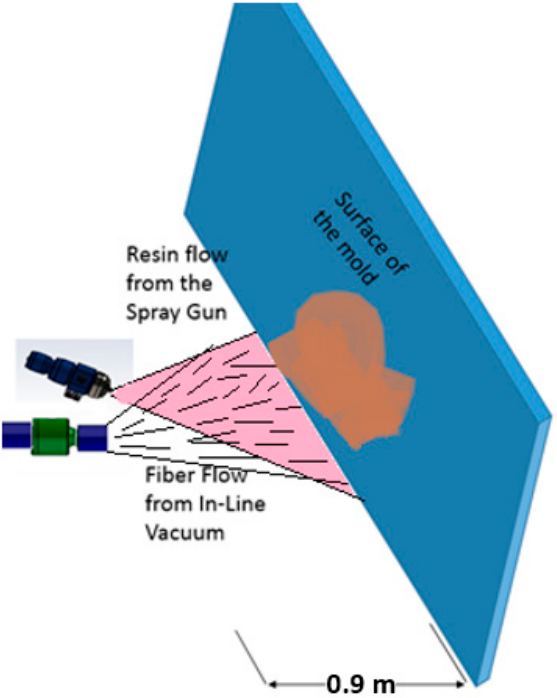
Figure 7. Schematic of the experimental set up of the fiber and resin external mixing.